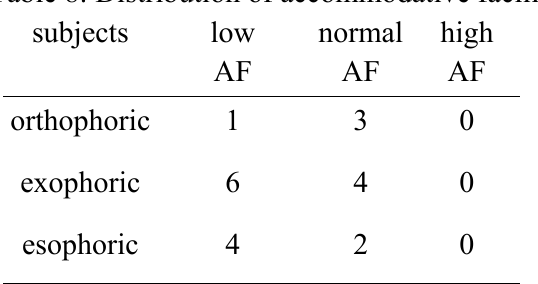
Table 8: Distribution of accommodative facility